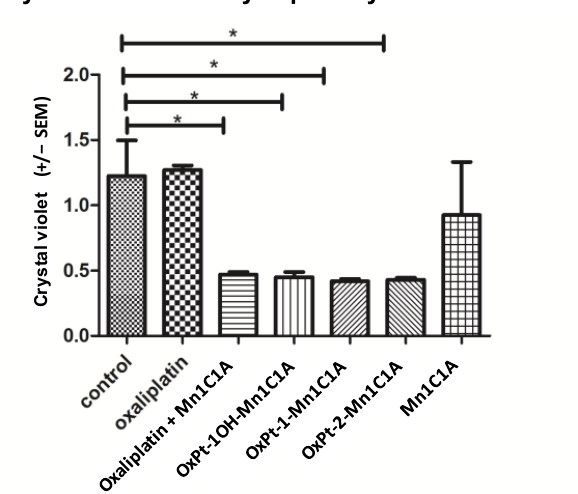
Figure 4. Crystal violet viability of fibroblasts (primary fibroblasts from murine skin cells) on day 2 after 24 h of treatment with vehicle, oxaliplatin, oxaliplatin associated with Mn1C1A, OxPt-1OH- Mn1C1A, OxPt-1-Mn1C1A, OxPt-2-Mn1C1A, and Mn1C1A alone at 2.5 µ M, 5 µ M, and 10 µ M: mean absorbance (at 570 nm). The p -values are denoted as follows: * p < 0.05. All the conjugate compounds and the association of oxaliplatin with Mn1C1A were more cytotoxic than oxaliplatin and vehicle on primary fibroblasts. The Mn1C1A complex showed no cytotoxic activity on murine primary fibroblast cells.